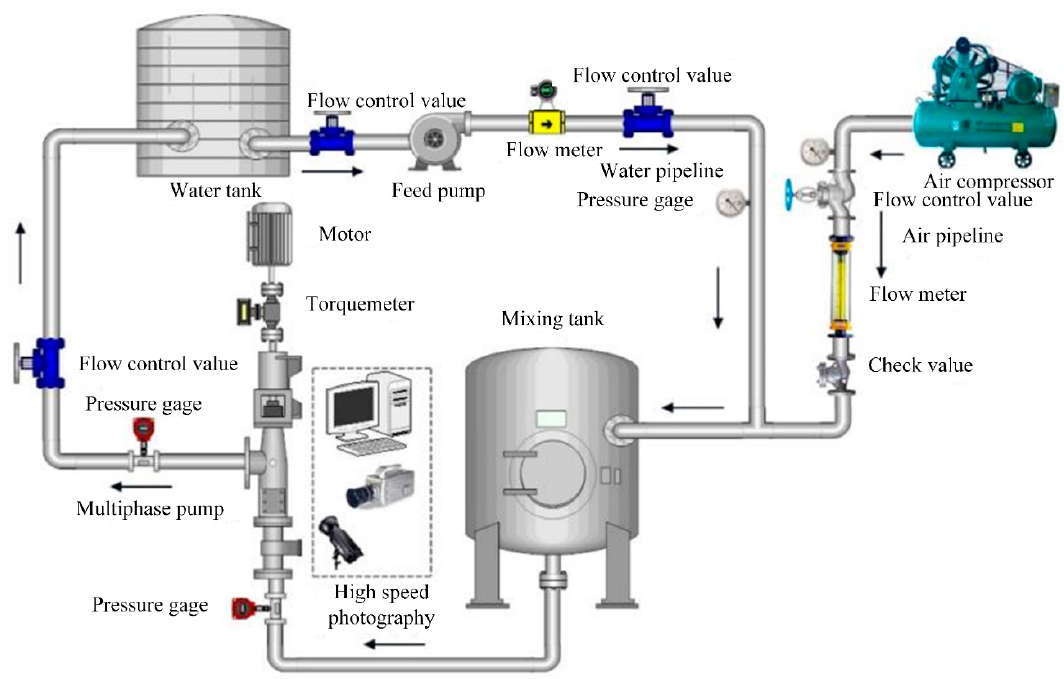
Figure 4. The multiphase pump test system.